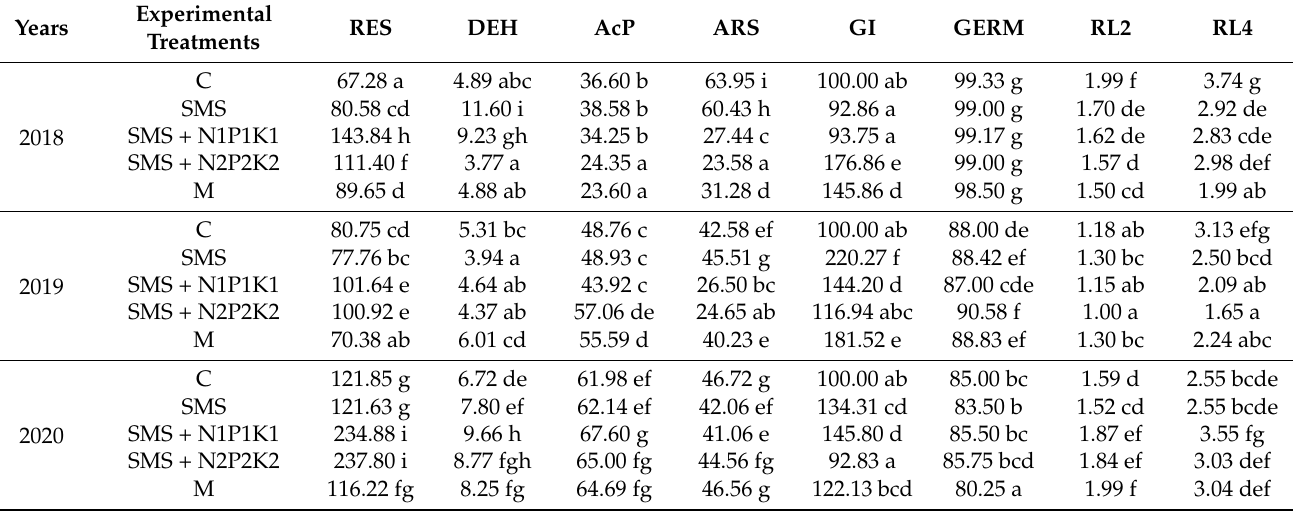
Table 3. Biochemical, enzymatic activity and soil phytotoxicity parameters (annual averages). Experimental Years Treatments